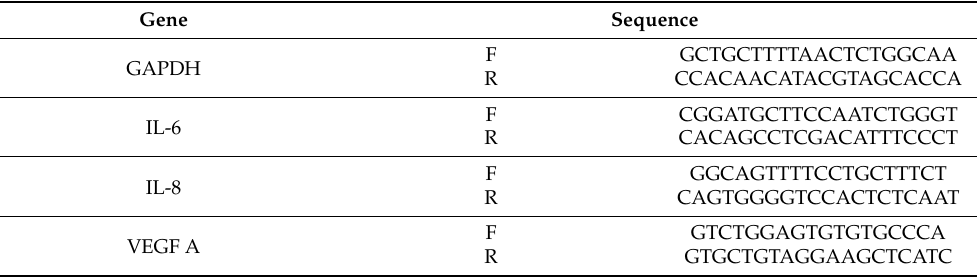
Table 2. Probes used for mRNA quantification by